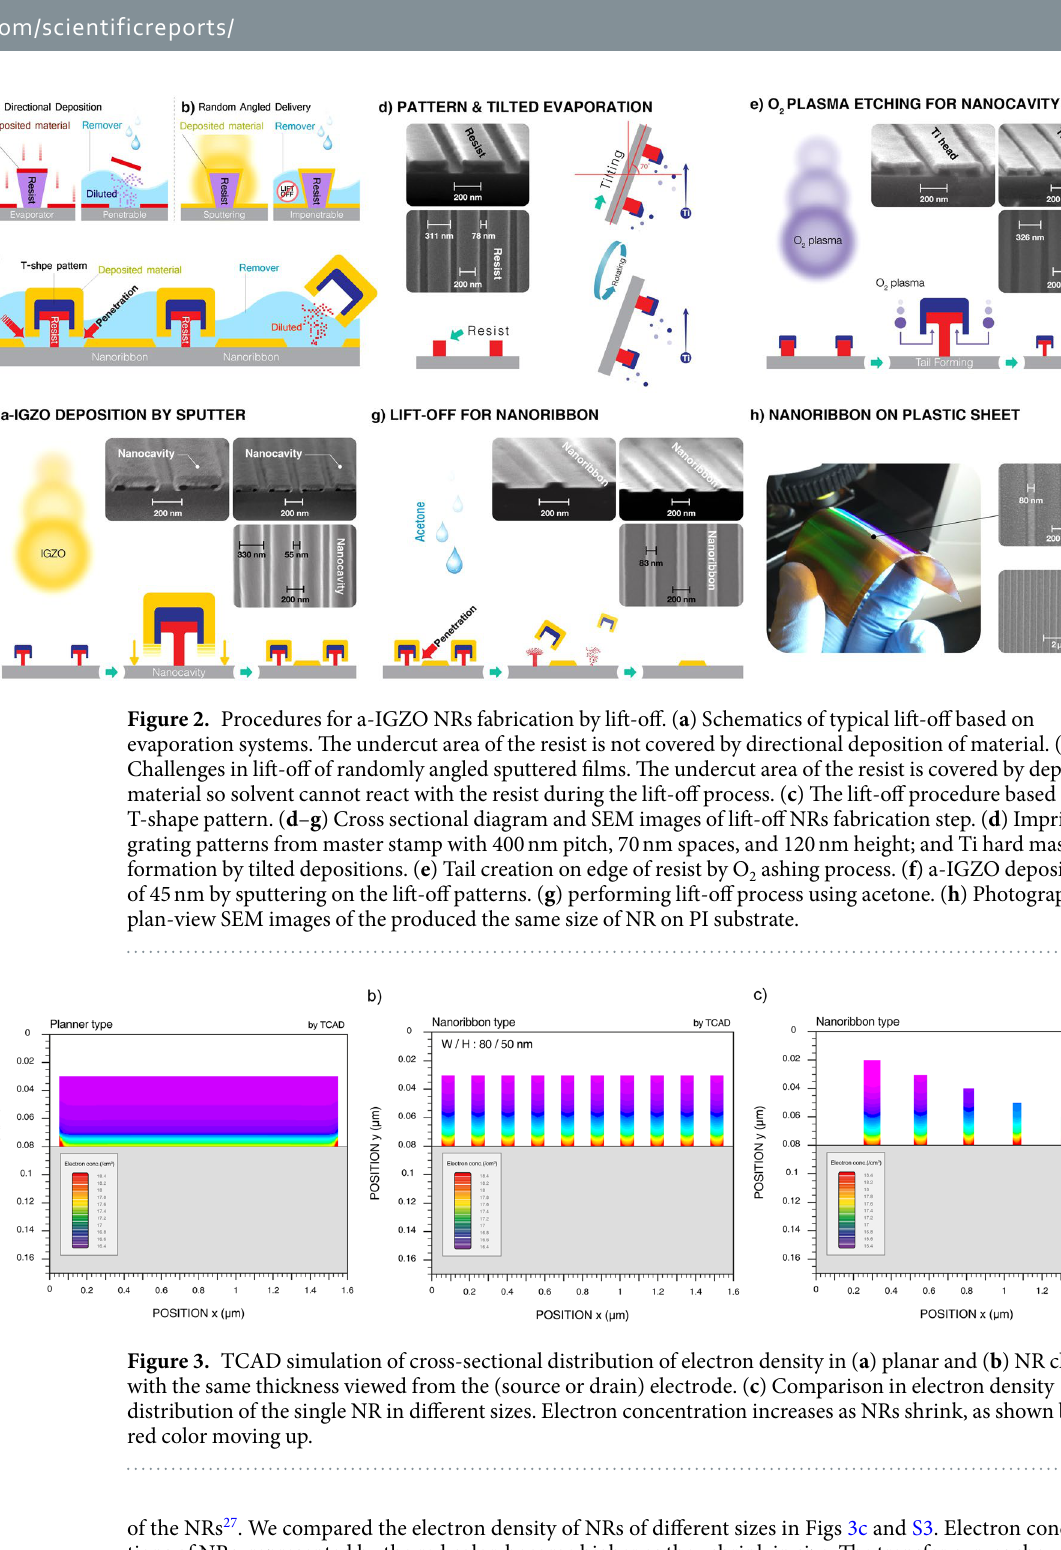
of the NRs 27 . We compared the electron density of NRs of different sizes in Figs 3c and S3. Electron concentra- tions of NRs, represented by the red color, become higher as they shrink in size. The transfer curves show higher drain current ( I D ) in larger NRs, but higher I D density in smaller NRs.